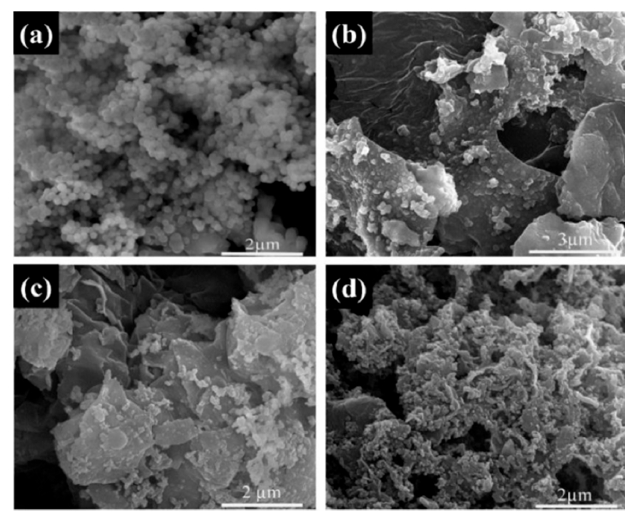
Figure 2. Scanning electron microscope (SEM) images of ( a ) SiO 2 , ( b ) GS-1, ( c ) GS-2, ( d ) GS-3.